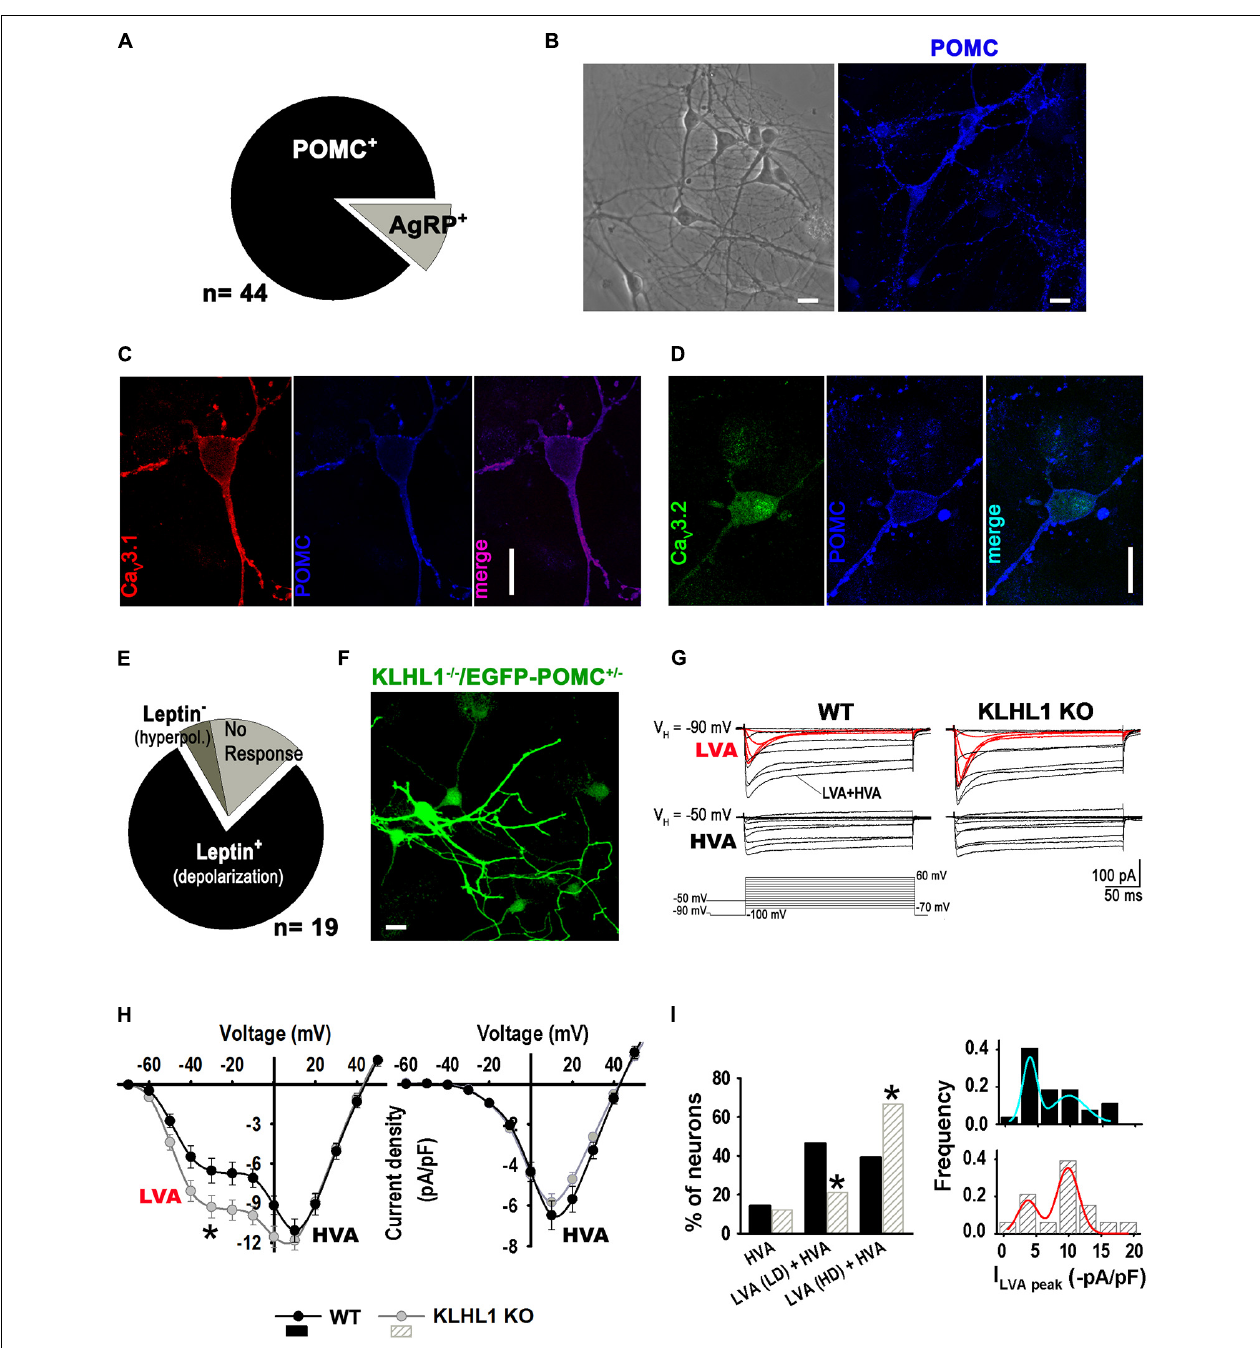
FIGURE 2 | Up-regulation of T-type current density in KLHL1-KO hypothalamic neurons. (A) Distribution of POMC + and AGRP + neurons in culture (the total neuron number was not assessed). (B) Left: Bright-field image of cultured hypothalamic KLHL1-KO neurons at 10 DIV. Right: Example of confocal image showing positive POMC + neurons (blue). (C,D) Detection of T-type α 1G (Ca V 3.1, red) and T-type α 1H (Ca V 3.1, green) in POMC neurons. Bar size, 20 µ m. (E) Summary of electrophysiology responses in KLHL1 KO hypothalamic cultured neurons. (F) Detection of POMC + neurons using neurons from KLHL1 KO mice crossed-bred with mice displaying EGFP + expression driven by the POMC promoter. (G) Average current traces obtained using the square voltage protocols shown. LVA refers to low-threshold activated calcium currents (T-type, Ca V 3 channels). HVA refers to high-threshold activated calcium channels. (H) Average current-voltage relationship (I-V curve) profiles in WT ( n = 26) and KLHL1-KO ( n = 28) hypothalamic neurons obtained from V H of –90 mV (left) or a V H of –50 mV (right), * P < 0.05 (from –60 to 0 mV), t -test; for –30 mV: t = 2.183 (df = 52). (I) Left: Comparison of the relative contribution of each neuronal group found: HVA, neurons expressing only high-voltage activated current; LVA (LD) + HVA, neurons expressing HVA and low LVA current density levels (LD, I LVA peak < 6 -pA/pF); and LVA (HD) + HVA, neurons expressing HVA and high LVA current density (HD, I LVA peak from 6 to 20 -pA/pF). * P < 0.05, Z- test. Right: LVA current density histogram fitted with superimposed Gaussian